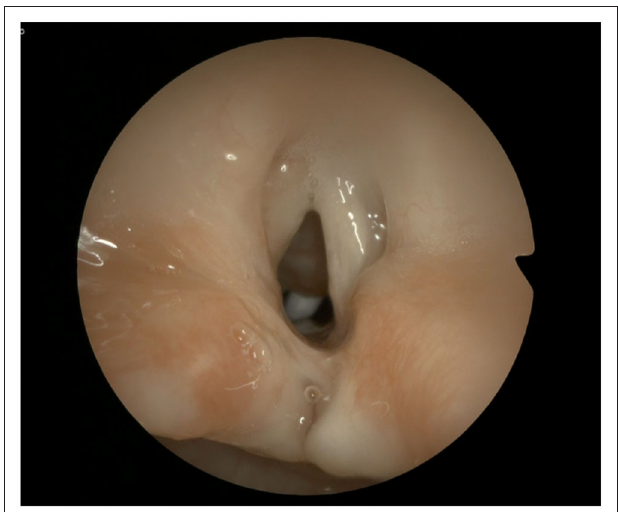
FIGURE 3 | Endoscopic posterior cricoid split with rib